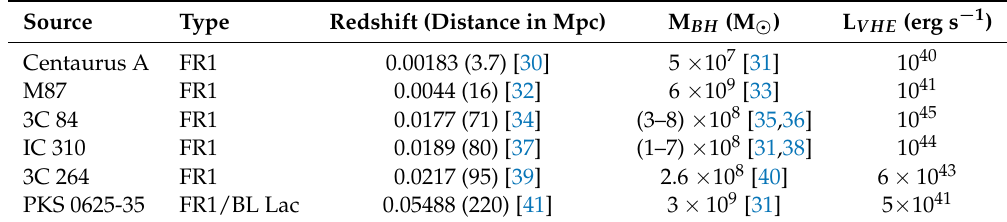
Table 1. Radio galaxies detected at TeV